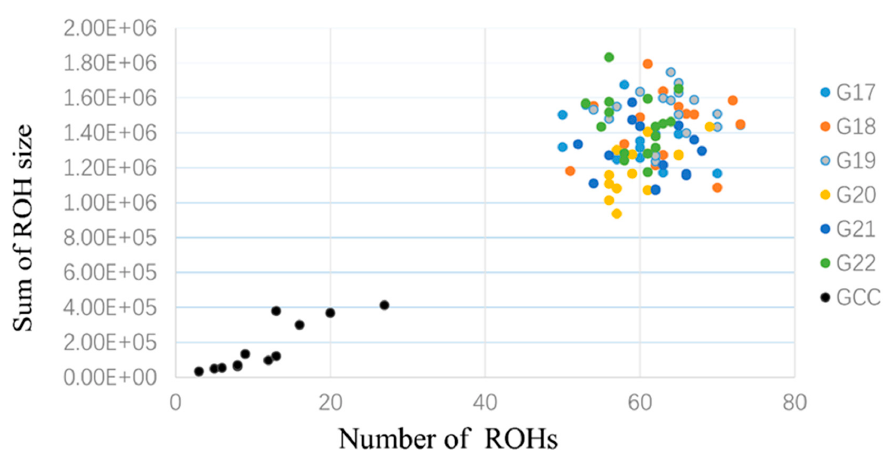
Figure 6. Number of ROHs and sum of ROH sizes for each inbred and non-inbred WZSP. Number of ROHs and sum of ROHs detected for each of 108 individuals genotyped by the Illumina Porcine 60 K SNP chip. Non-inbred pigs are shown in black, and six generations in inbred pigs are indicated by various colors.